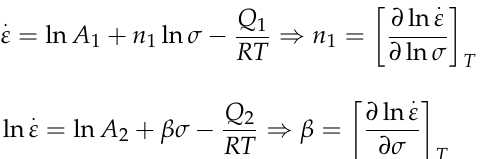
. . ε − ln σ ( a ); ln ε − σ ( b ); plots of ln